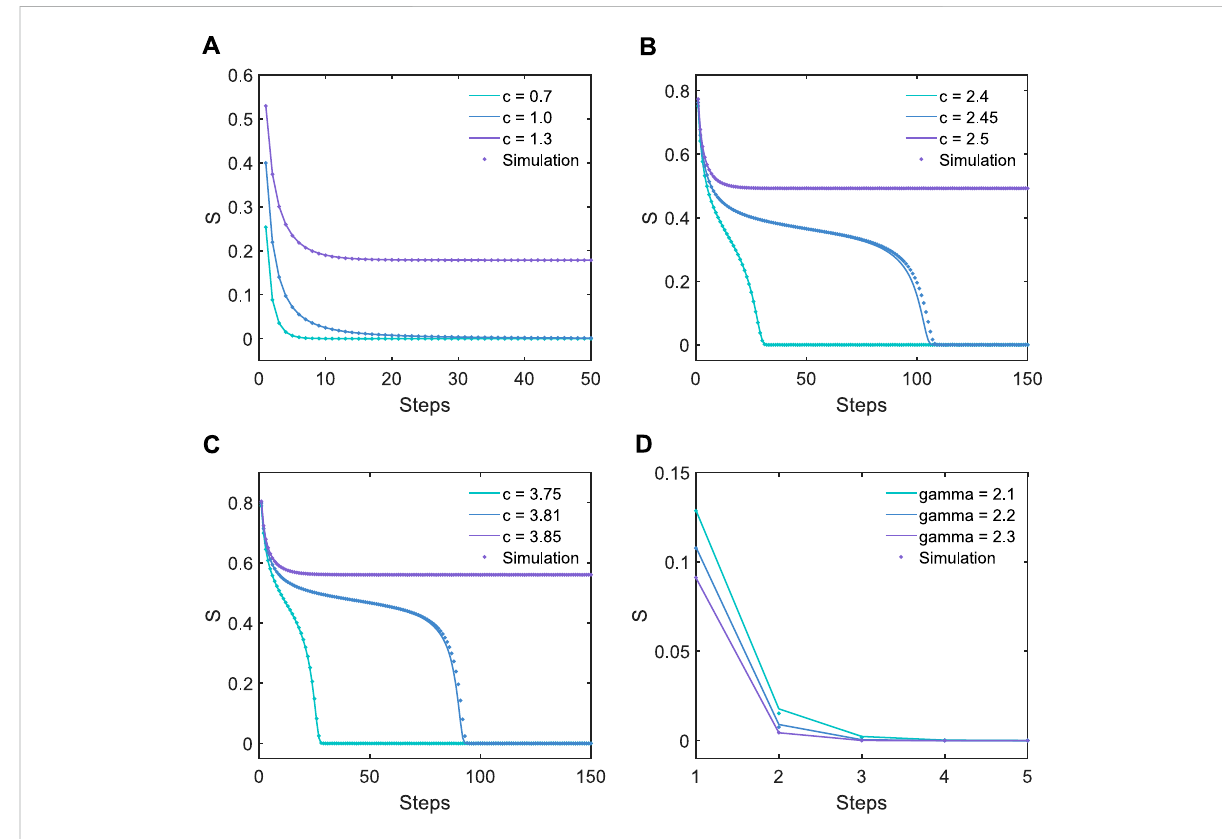
Theoretical results (solid lines) and numerical simulation results (dots) for k -core decompositions on multiplex networks with identical parameters.Allsimulationsareperformedonnetworkswith10 7 vertices,exceptthatinthesimulationsof c =2.45 (B) , c =3.81 (C), and γ =2.1 (D) ,the networks contain 5 × 10 7 vertices. (A) Results of the (1,1)-core pruning process on three different two-layer uncorrelated ER networks. It should be noted that in this case, it shows a continuous phase transition. (B) Results of the (1,1,1)-core pruning process on three different three-layer uncorrelated ER networks. In this case, the networks exhibit a discontinuous phase transition. (C) Results of the (2,2)-core pruning process on three different two-layer uncorrelated ER networks. It should be noted that in this case, the networks exhibit a discontinuous phase transition, different from the case shown (A) . (D) Results of the (2,2)-core pruning process on three different two-layer uncorrelated SF networks. In this case, the (2,2)- core does not exist for γ >